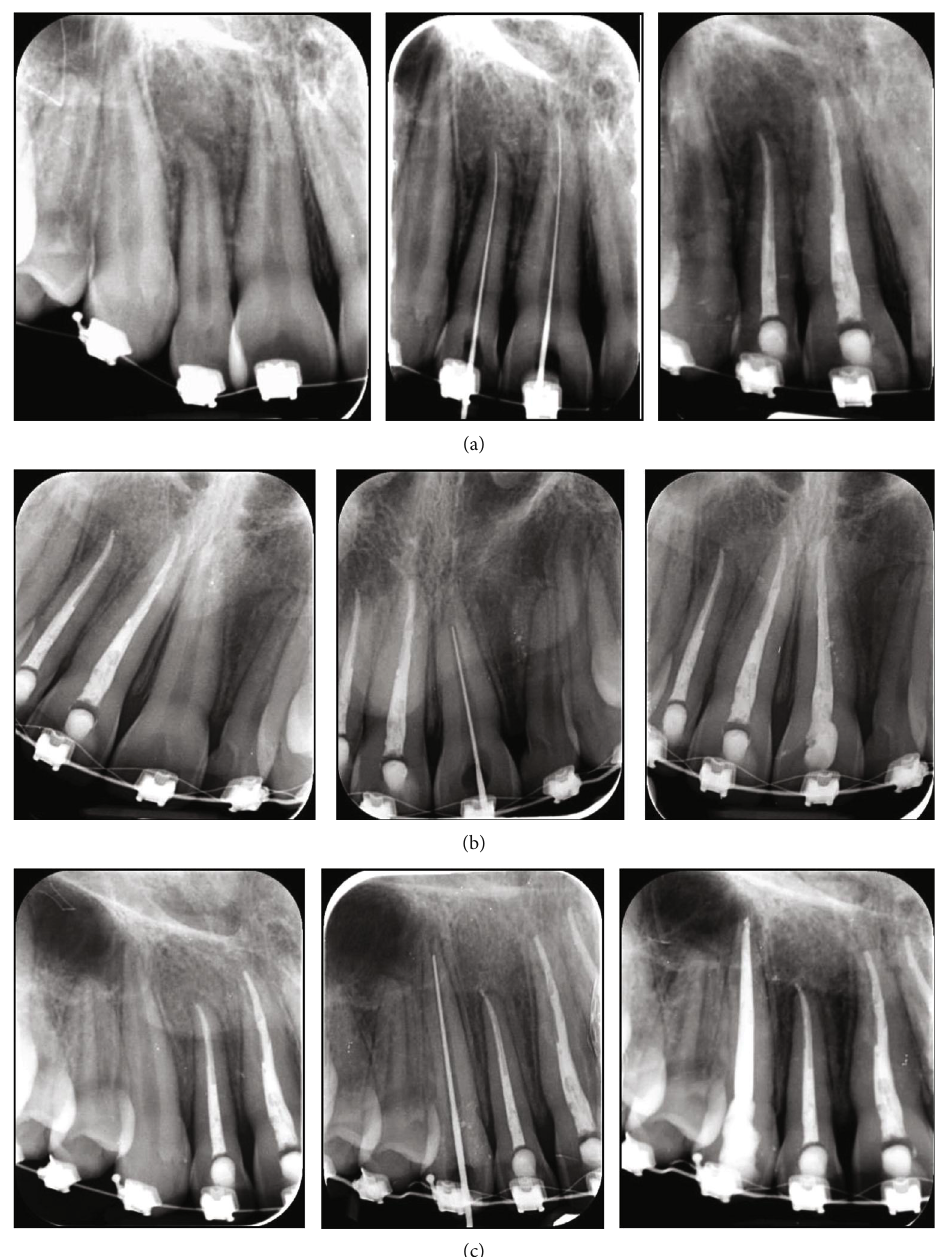
Figure 11: Periapical radiographs of the endodontic treatment of the (a) maxillary right central and lateral incisors, (b) maxillary left central incisor, and (c) maxillary right canine. The periapical radiographs (left) before endodontic treatment, (middle) during root canal working length measurement, and (right) after endodontic preparation and root canal and fi